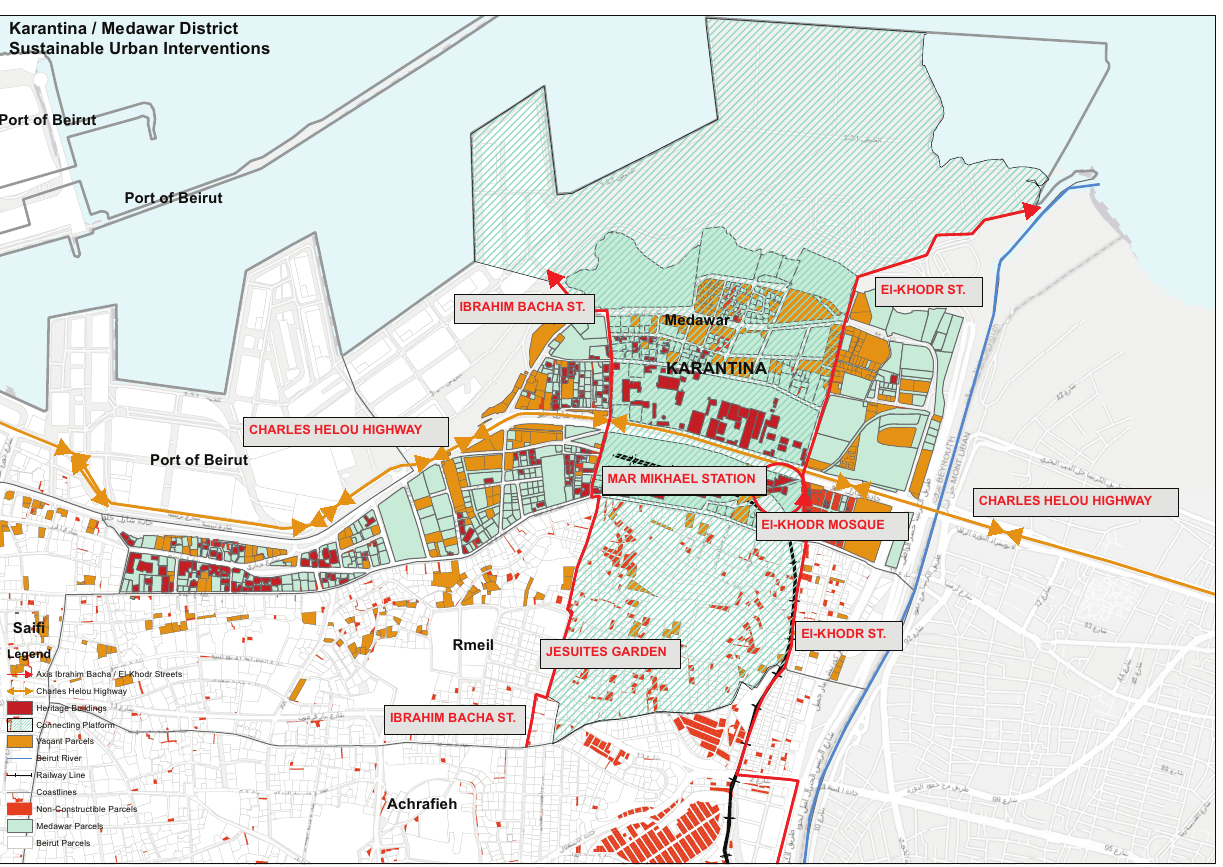
Figure 4. BUD. Study of the urban typo‐morphology of the area and its connectivity to neighboring parts: Case study of the areas of Medawar/Karantina–Rmeil in Municipal Beirut. Source: Author’s work based on and map from Aouad and Kaloustian (2021, p.